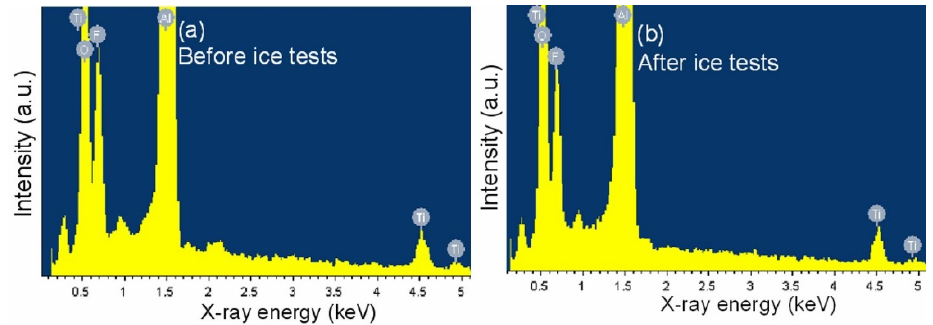
Figure 8. EDX spectra of Tef/TiO 2 /ns-Al ( a ) before and ( b ) after ice adhesion tests.